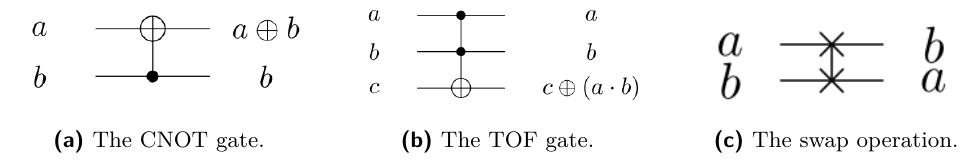
Circuit 1: Basic quantum gates used in this paper, beyond